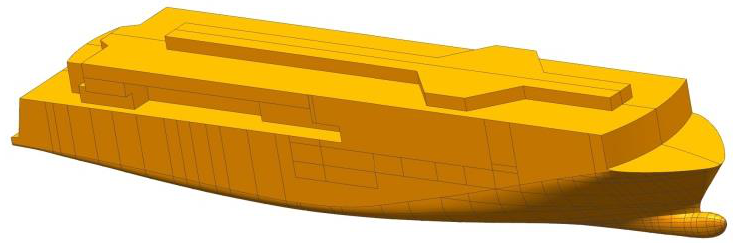
Figure 1. CAD-model of the MT RoPax used in the numerical simulations. Table 1. Main data of the vessel in intact (test) condition.